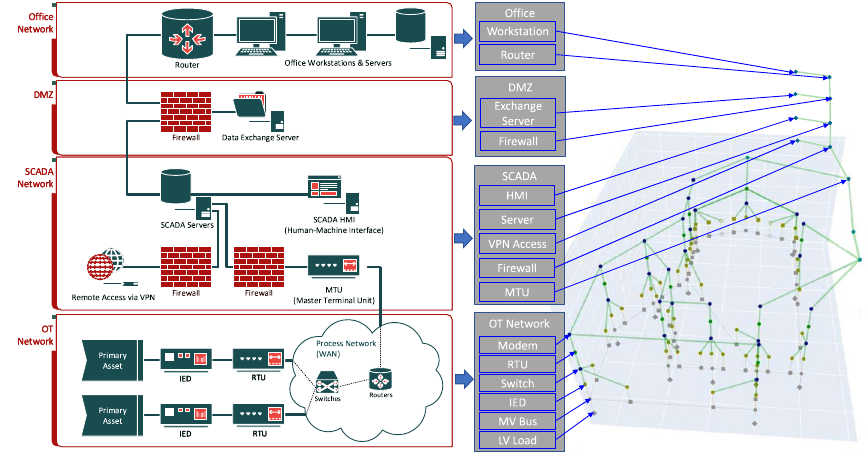
Fig. 1 Illustration of the SG infrastructure based on the Purdue reference model, representing a future-oriented SCADA system that is connected to the primary equipment via dedicated and/or public communication infrastructure (van der Velde et al. 2021). The right side represents the graph-based formalism of the infrastructure as a SB (Klaer et al.